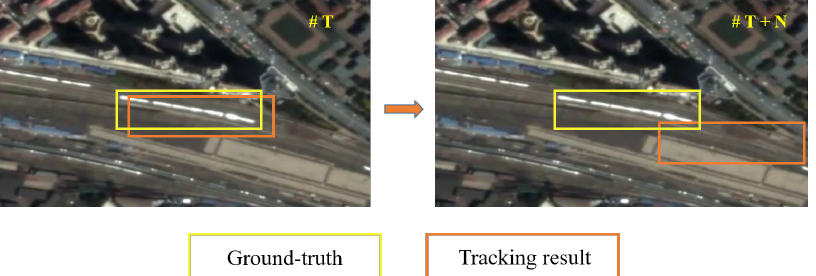
Figure 1. The phenomenon of model drift. When the overlap between the bounding-box of the tracking result and the bounding-box of ground-truth is less than the given threshold, it is considered that the tracker loses the target, also known as model